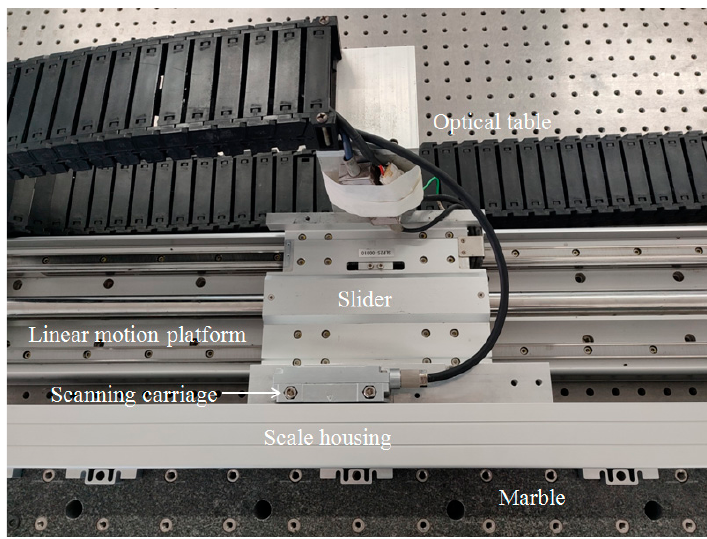
Figure 10. Experimental setup.